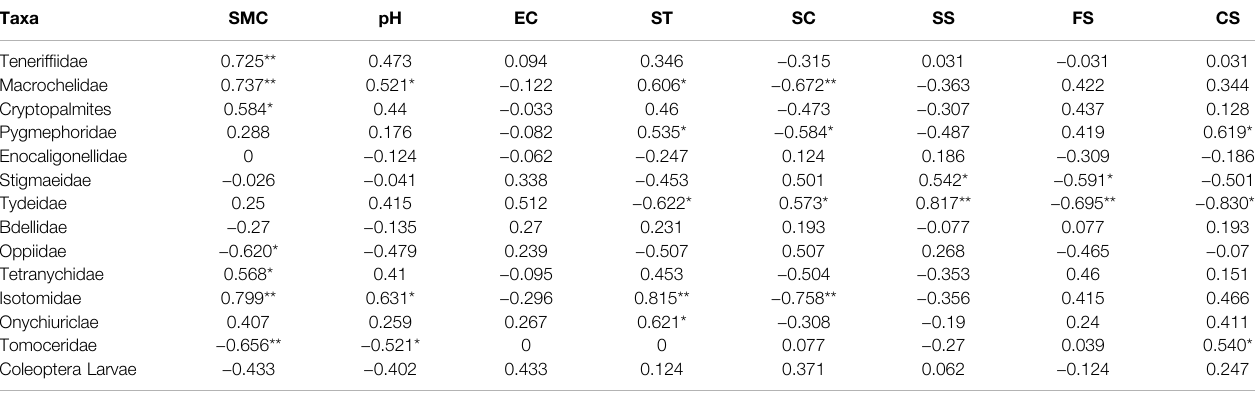
TABLE 4 | Correlation coef fi cients (Spearman) between single microarthropod groups and environmental factors. * p < 0.05, ** p < 0.01. SMC = soil moisture content, EC = electrical conductivity, SC = soil clay, SS = soil silt, FS = fi ne sand, CS = coarse sand, ST = soil temperature. Taxa